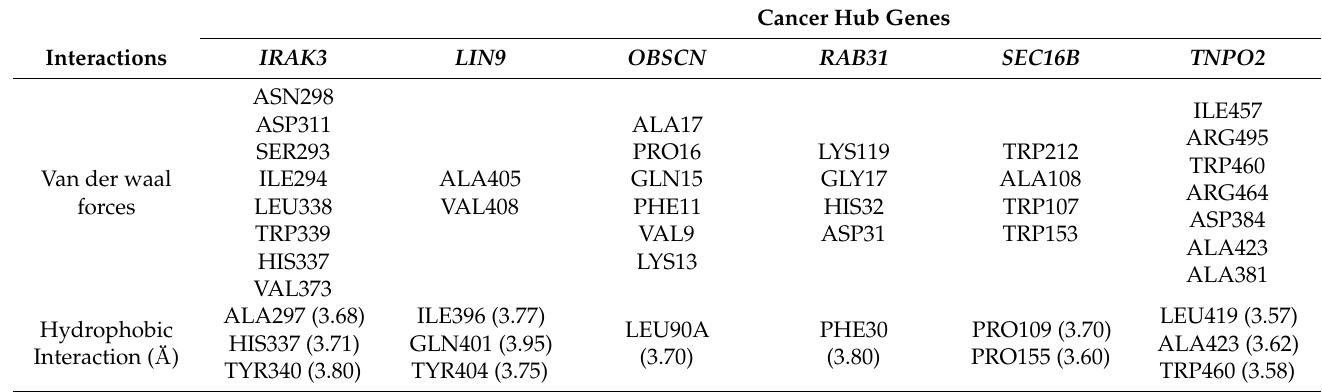
Table 3. Cont. Cancer Hub